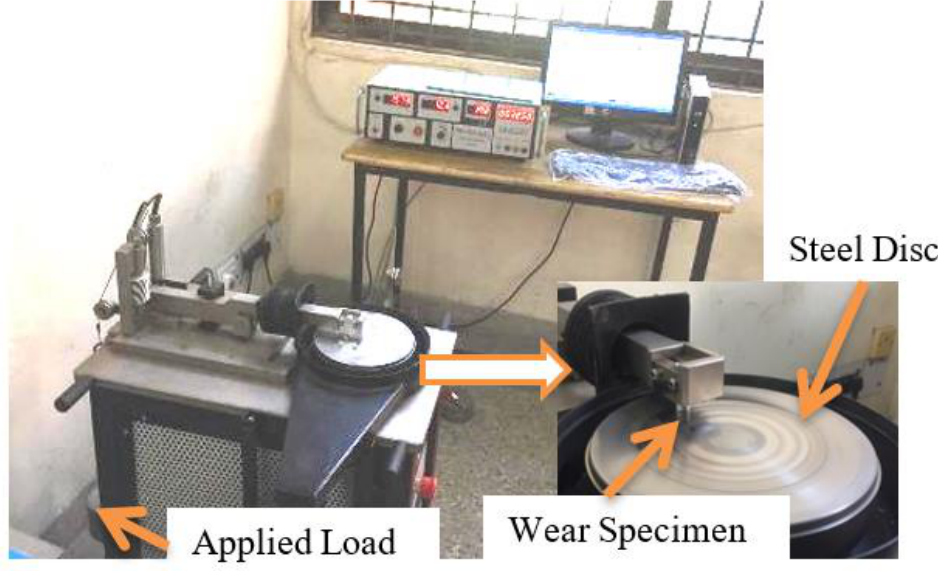
Figure 3. Photograph of pin on disc machine.